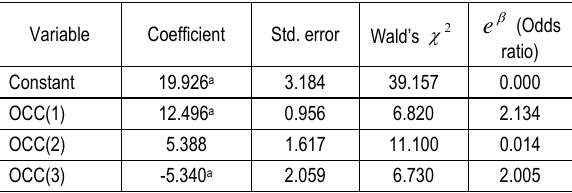
Table 5. Logistic regression results of the credit risk